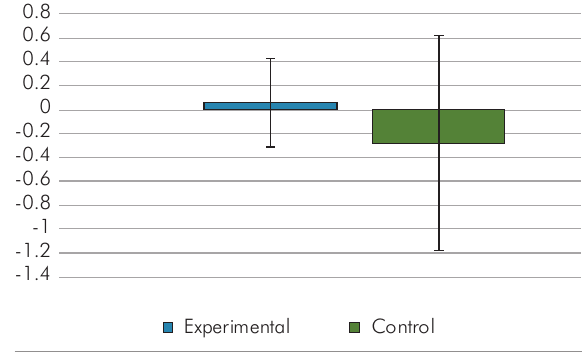
Figure 2. CGRP results for experimental and control teeth in intracanal laser application group; there was no significant difference between experimental and control teeth in the intracanal laser application group in terms of the total CGRP level change in the GCF before and after treatment (p > 0.05).